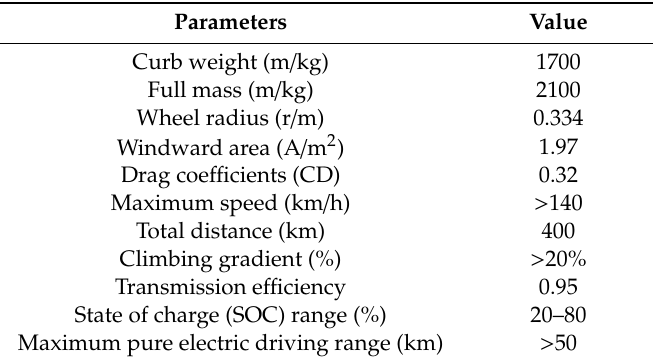
Table 1. The main parameters for